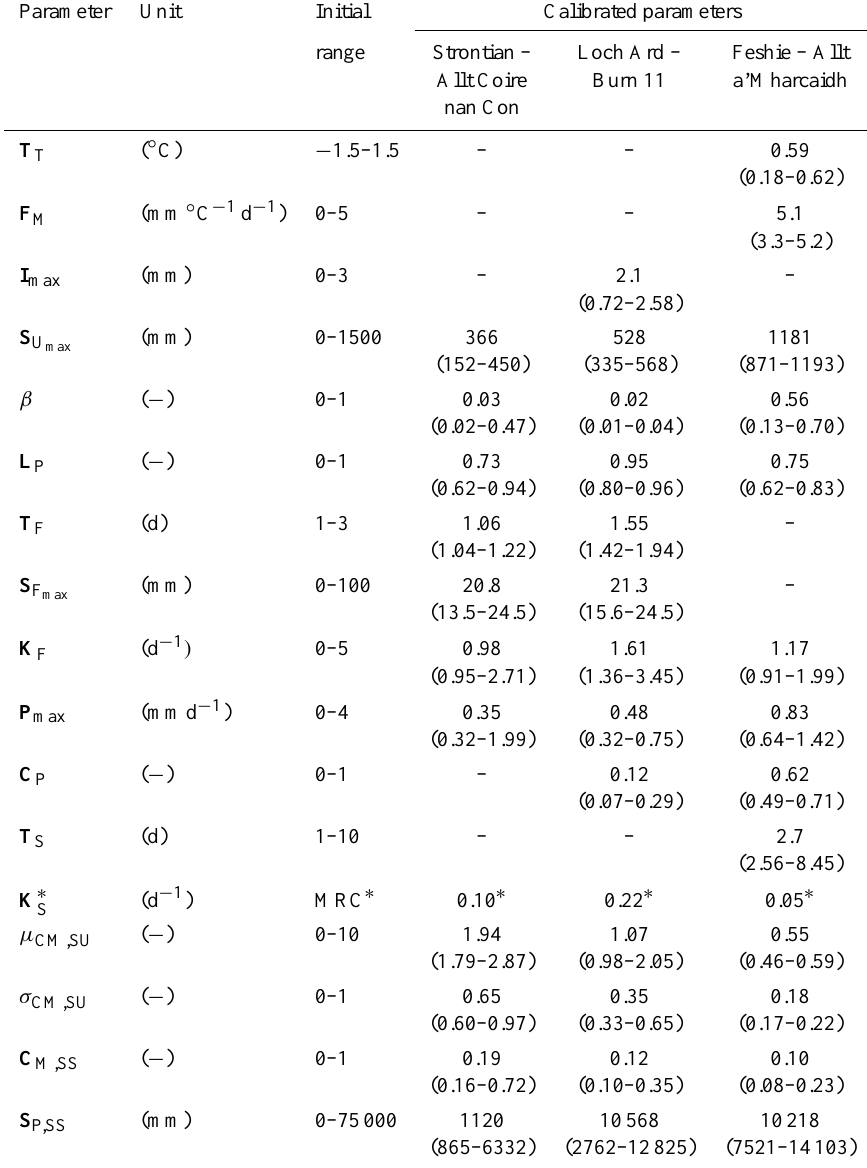
Table 3. Parameters used in the three model setups with the initial sampling range as well as the optimal parameters and the parameter ranges of Pareto members (in brackets) for the three study